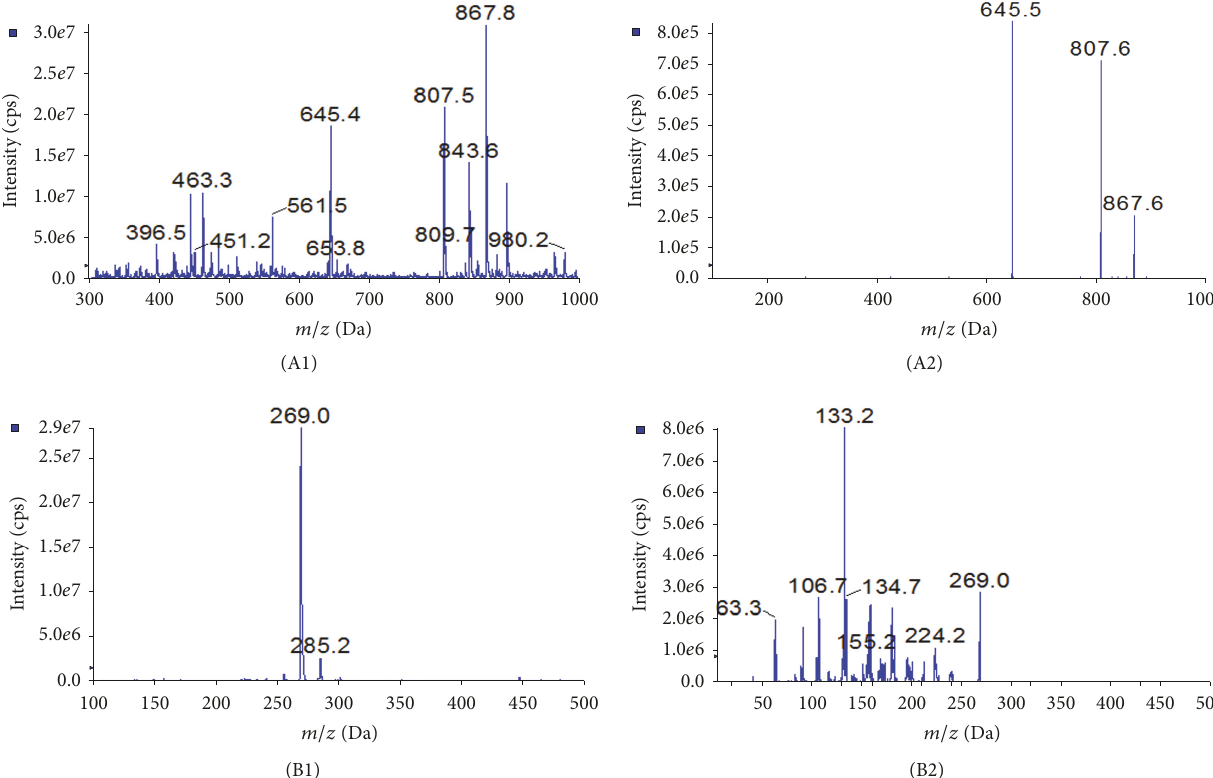
Figure 2: (1) Full-scan mass spectrum of epimedin B (A1) and internal standard (genistein, B1). (2) Product ion spectrum of epimedin B (A2) and internal standard (genistein,